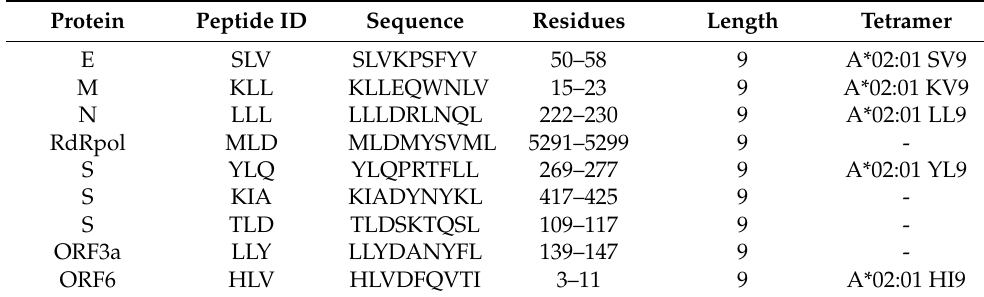
Table 1. SARS-CoV-2 peptides and tetramers restricted by